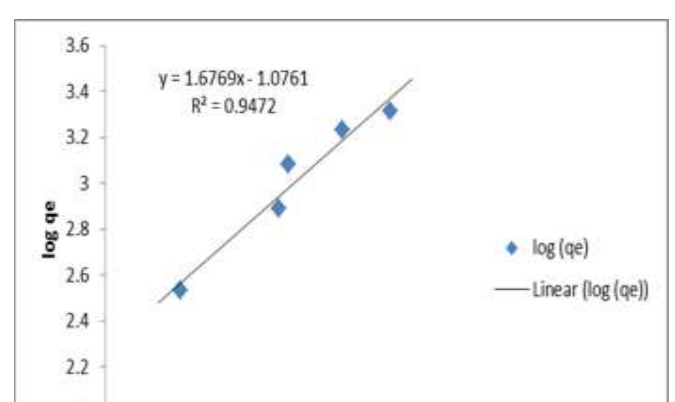
Fig.7: Langmuir isotherm model.